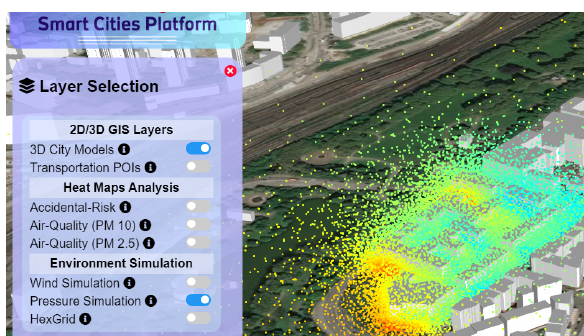
Figure 1. Screenshot of our Smart Cities Platform employing OGC standards at the back